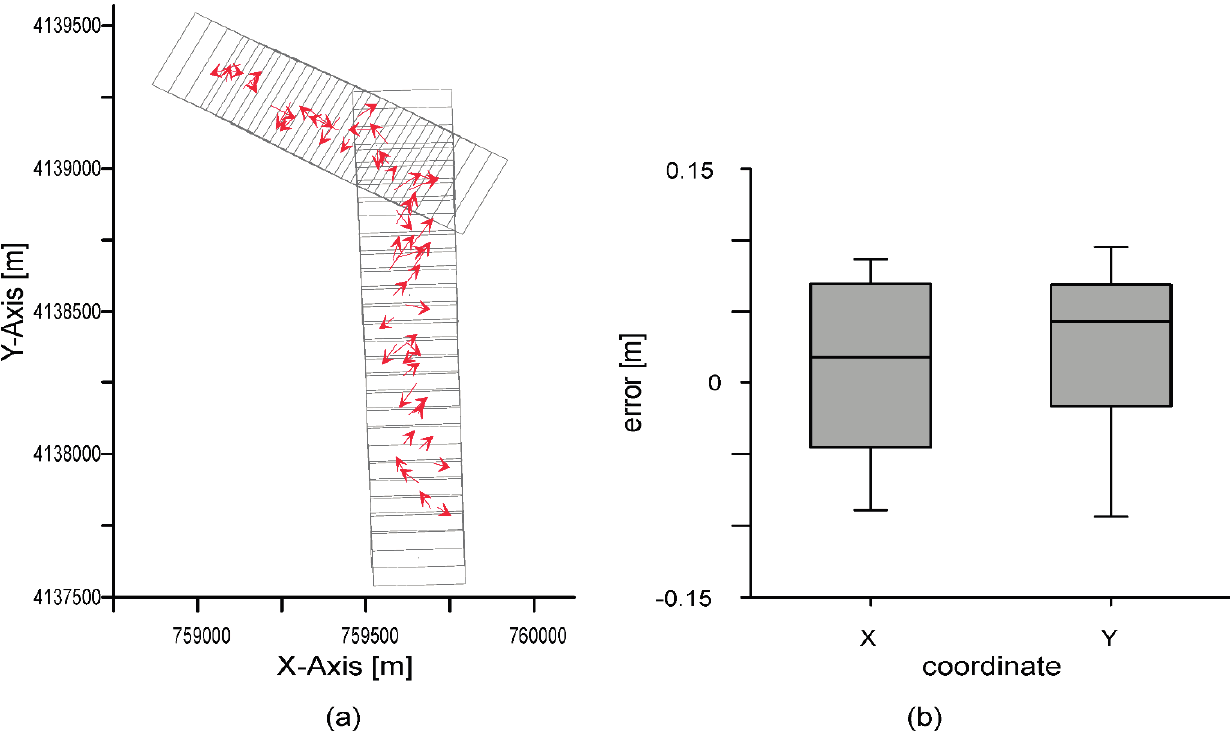
Figure 3. Comparison check points from GPS and UAV orthophoto: ( a ) distribution vector error; ( b ) box-plot graph of errors in coordinates X and